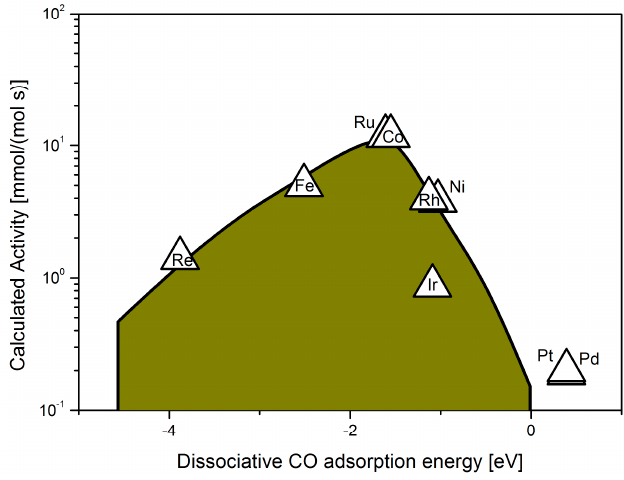
Figure 6. Activities of different supported transition metals as a function of the reaction energy for dissociative CO chemisorption at 550 K. Adapted from Bligaard et al. [206].